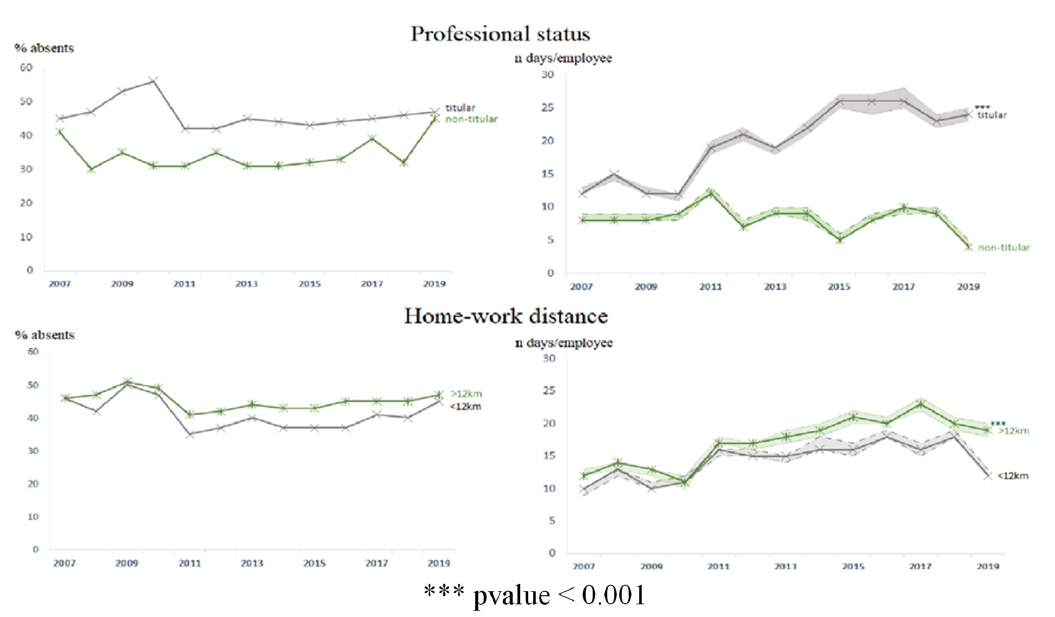
Figure 2. Evolution in the proportion of absentees and the number of days of absence per absent agent by occupational factor (expressed in median (C49–C51)).